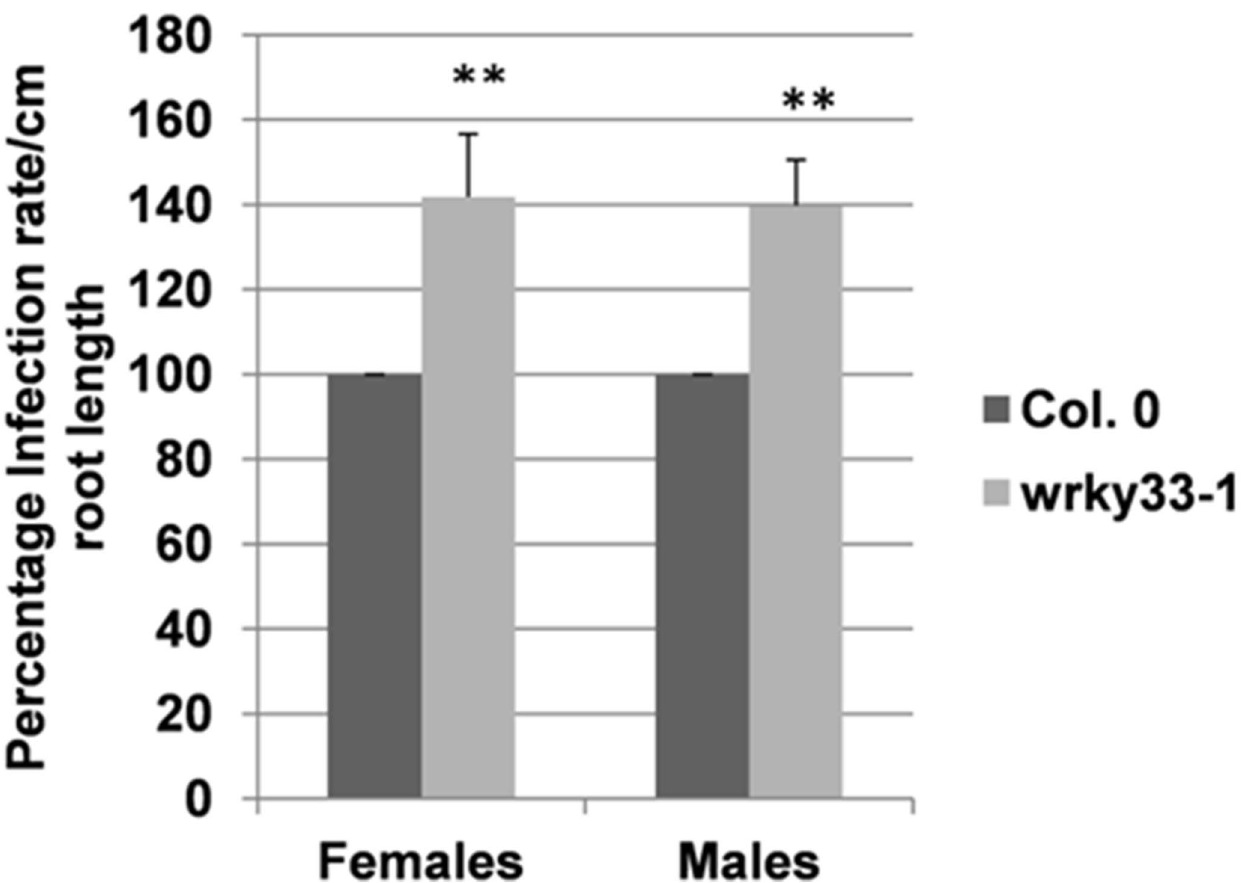
Figure 7. Nematode resistance test for wrky33 knock out mutant. The resistance of wrky33 knock out mutant ( wrky33-1 ) was compared to wild type plants after infection with H. schachtii . A: Number of male and female nemaodes per cm of root length calculated at 15 dpi setting the wild type as 100%. Asterisks indicate significant differences (P , 0.01; T-test). The statistical significance was determined by three independent replicates. Values are means 6 SE, n=15. The bar shows standard error for the mean.